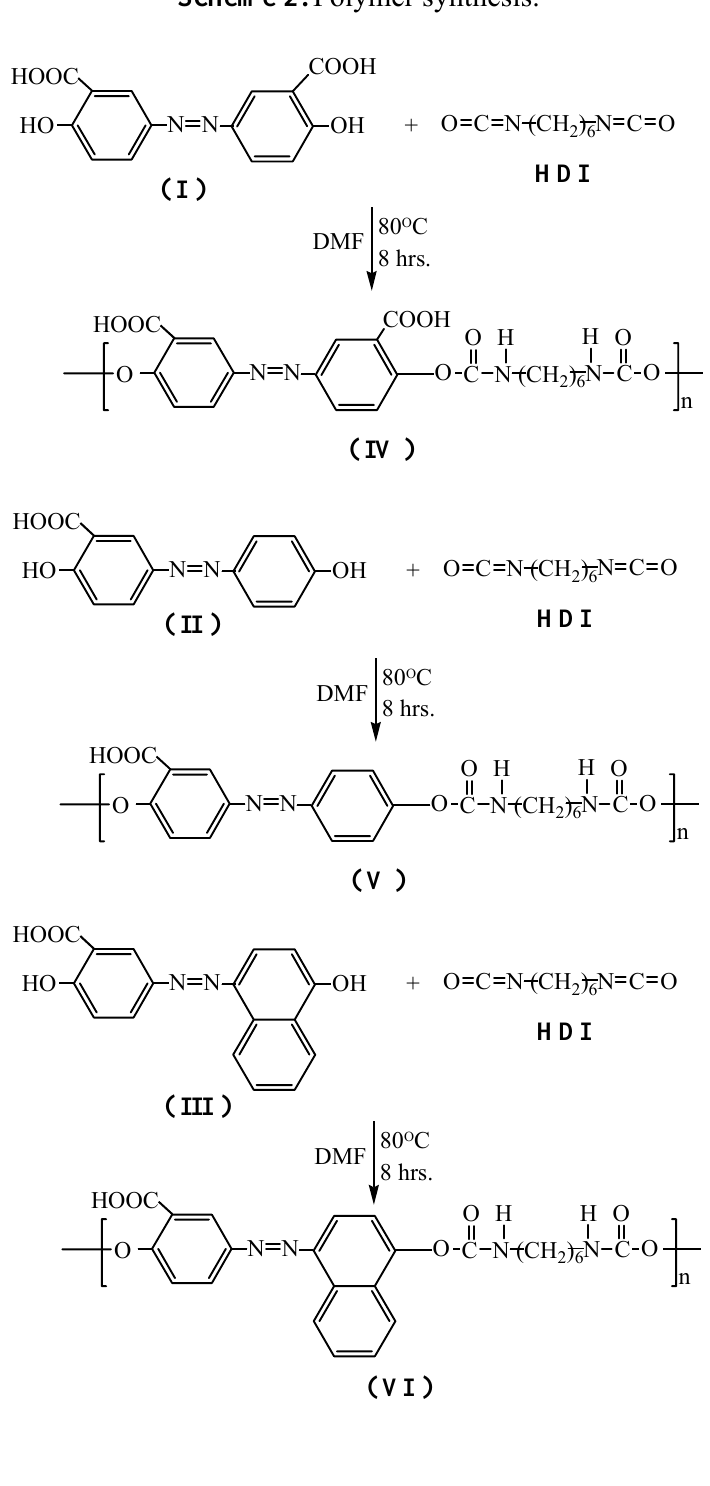
Scheme 2. Polymer